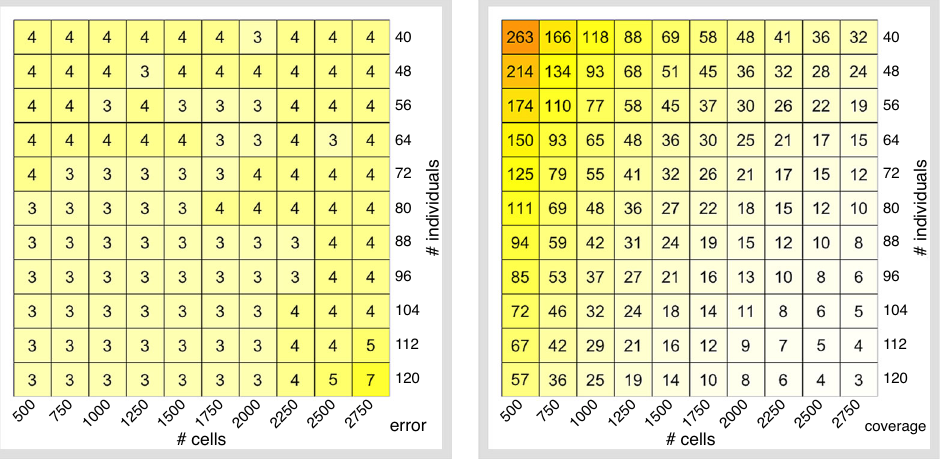
Fig. 3 Cell-type misclassi fi cation error rate (%) and coverage (thousands of reads per cell). a Cell-type misclassi fi cation error; b coverage. Color scales correspond to the magnitude of the values in each cell of the